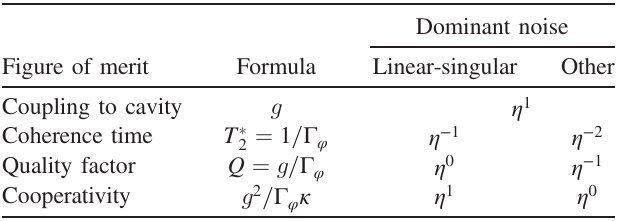
represents the Josephson J